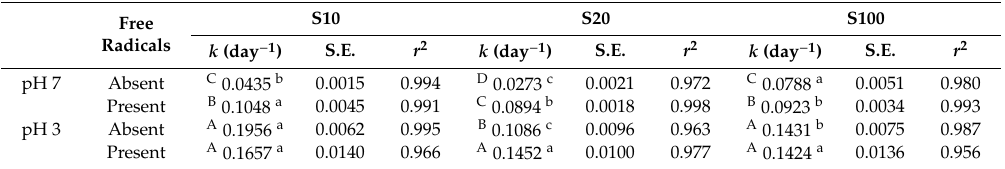
The values with di ff erent capital-letter superscripts in a same column are significantly di ff erent by Chow test ( p < 0.05). The values with di ff erent small-letter superscripts in a same row are significantly di ff erent by Chow test ( p < 0.05). S.E. indicates the standard